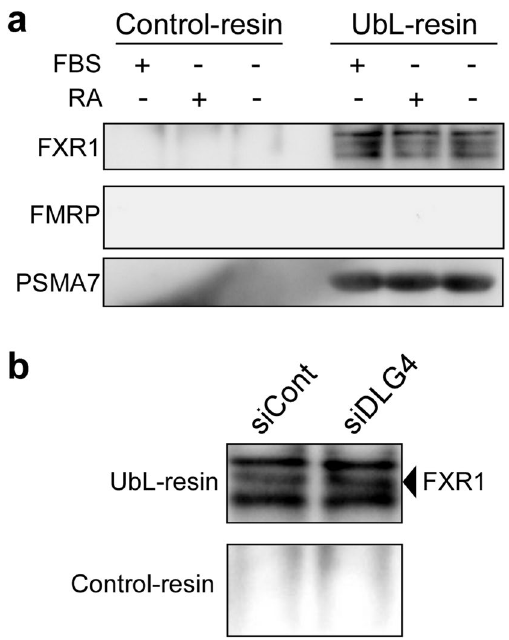
Figure 4. Association of FXR1 protein with proteasome. ( a ) Association between FXR1 and proteasome. Proteasomes were collected by precipitation with the UbL-resin and Control-resin from N2a cells cultured under growth conditions (FBS +) and serum-free differentiation conditions with (FBS-/RA +) or without (FBS-/RA-) retinoic acid. The collected proteasomes were examined by western blotting for FXR1, FMRP and PSMA7 (an essential subunit of the 20S proteasome complex). ( b ) Association of FXR1 with proteasome under Dlg4 -knockdown conditions. Proteasomes were collected from N2a cells treated with siDLG4 and siCont, and examined by western blotting for FXR1 as in ( a